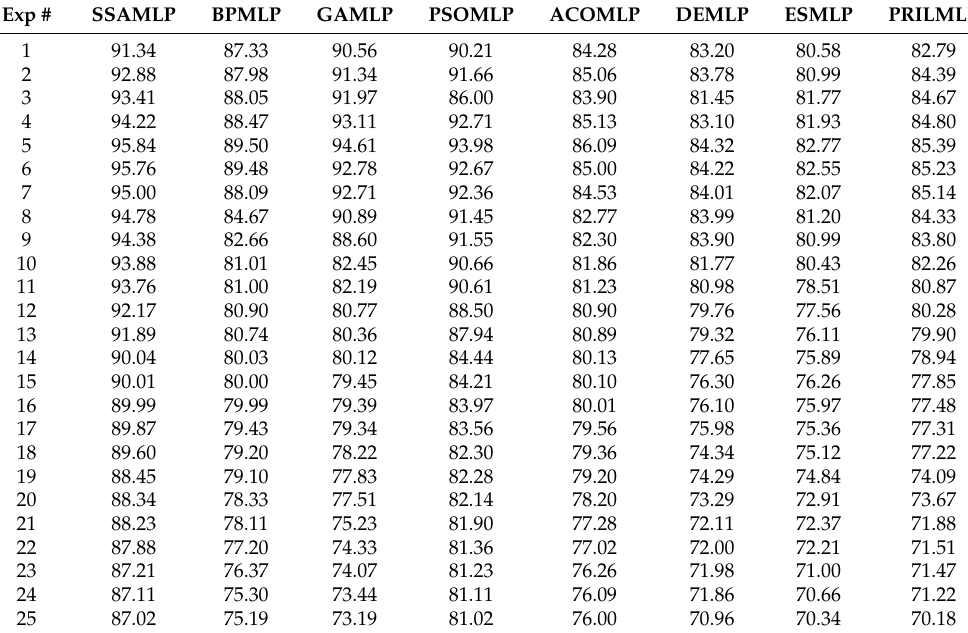
Table 5 and Figure 5 show the accuracy results of the proposed SSAMLP model versus other algorithms that are integrated into the MLP algorithm. Table 5. Accuracy results of the SSA-MLP against other algorithms based on different experi- ment